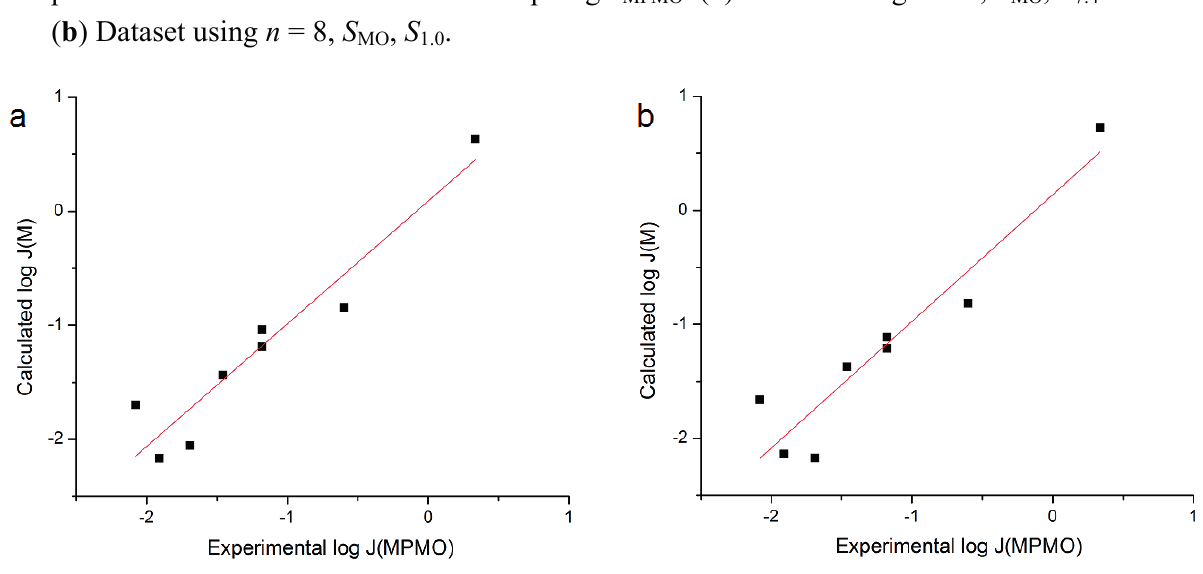
. ( a ) Dataset using n = 8, S MPMO